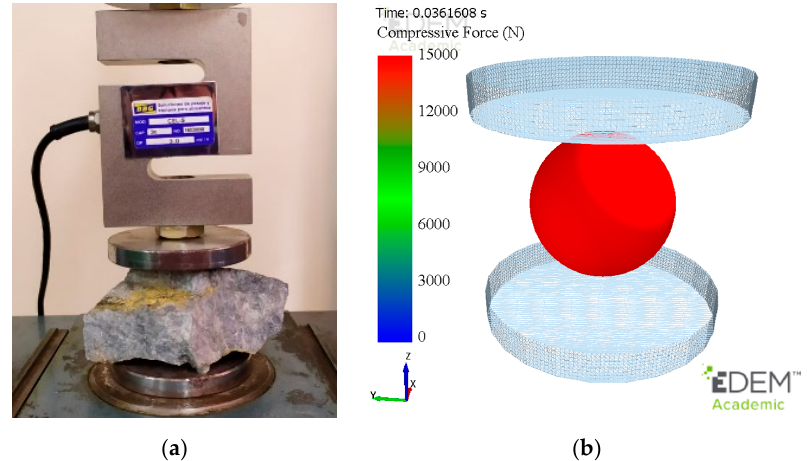
Figure 5. Experimental ( a ) and DEM simulation ( b ) set up of the single particle uniaxial compression